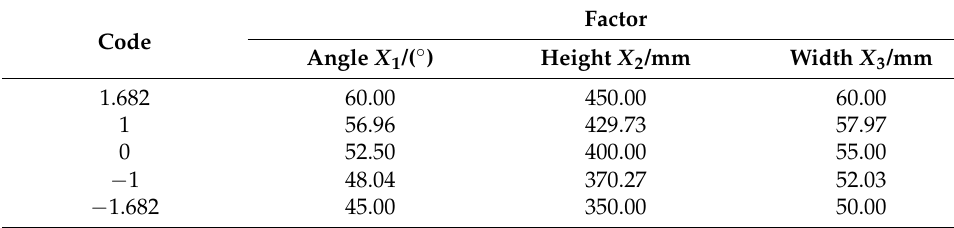
Table 3. Factor level coding table.